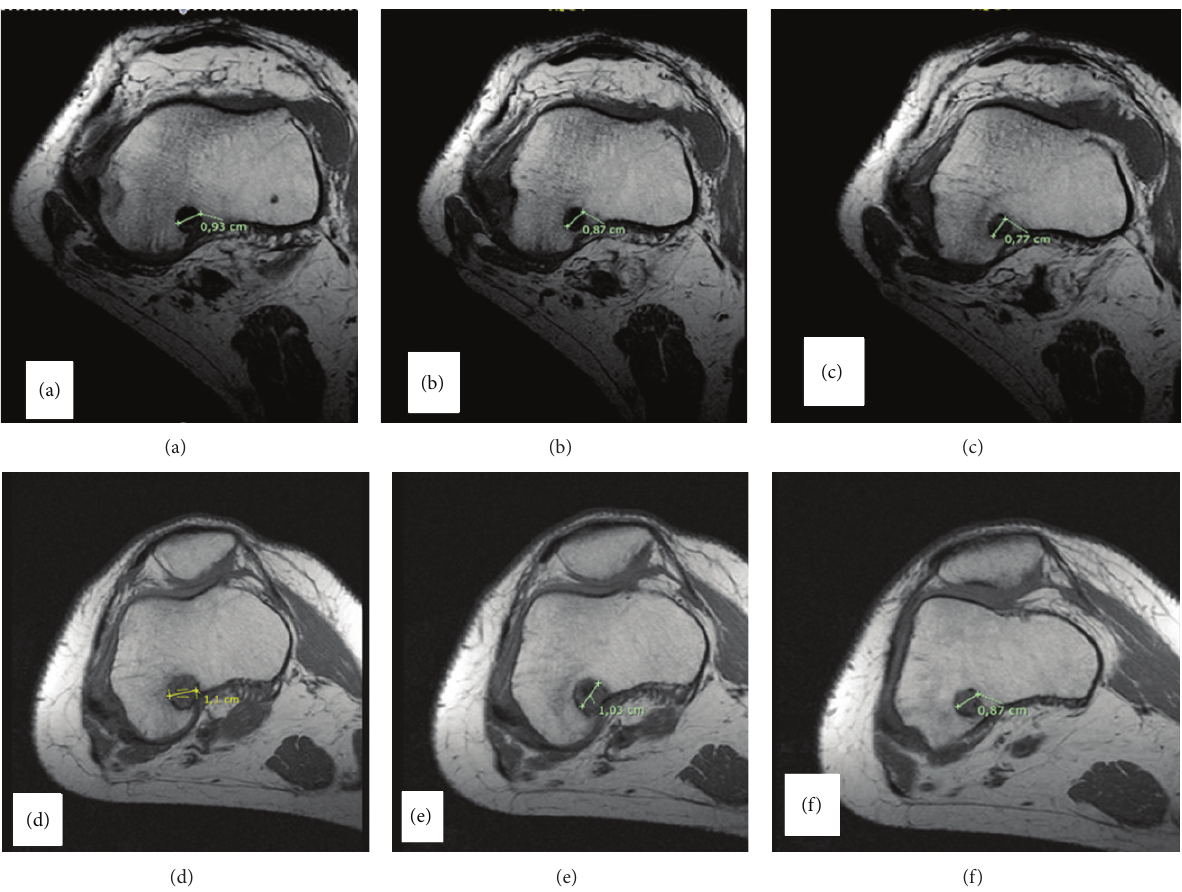
Figure 4: Comparison of femoral tunnel’s axial MRI cuts performed on the same patient 1 and 12 months following ACL reconstruction. (a) Proximal 1 month, (b) middistance 1 month, (c) distal 1 month, (d) proximal 12 months, (e) middistance 12 months, and (f) distal 12